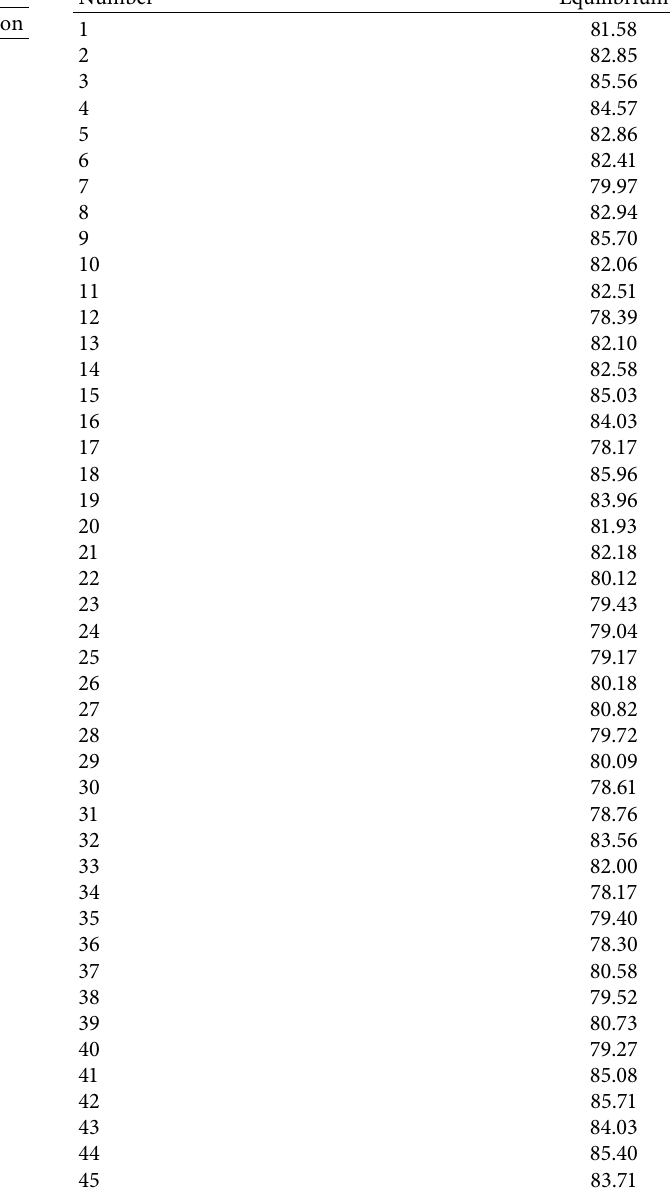
Table 1: Evaluation of regional collaborative remote sensing ob- servation technology.